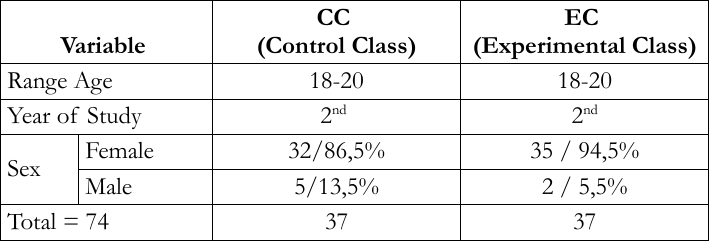
Table 1. Characteristic and Distribution of the